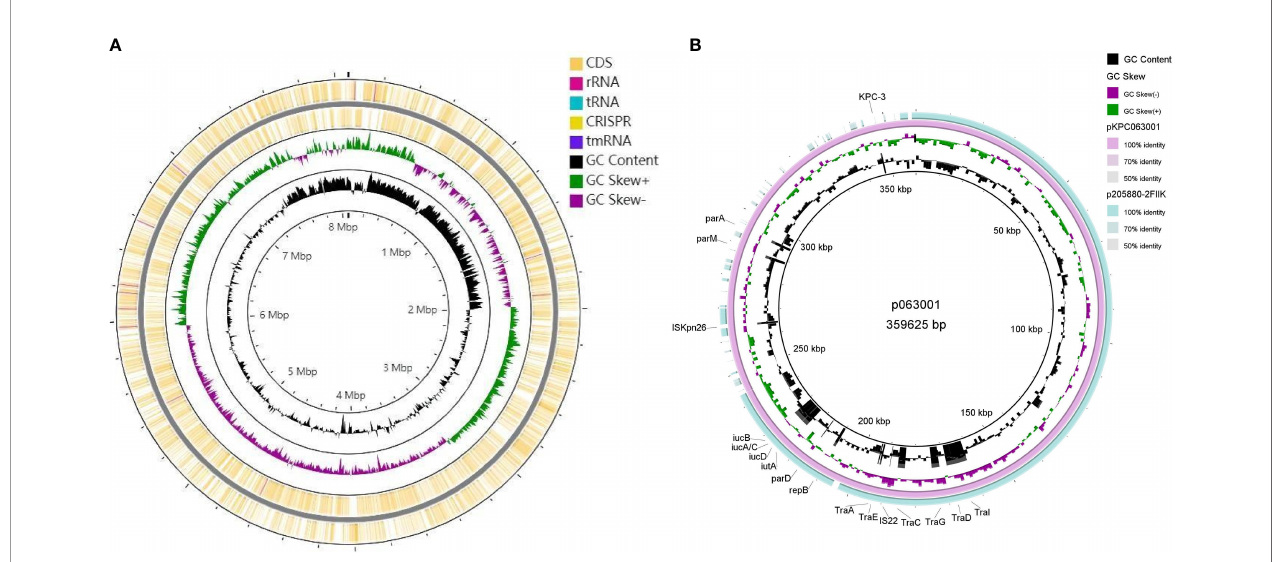
FIGURE 4 | Schematic circular genome of CRKP063. (A) Chromosome circle map. From the outside to the inside, the fi rst two circles represent the coding sequences on the positive and negative chains. The third circle represents the GC skew value. When the value was positive, the positive chain was more likely to transcribe the CDS, and when it was negative, the negative chain was more likely to transcribe the CDS. The fourth circle represents the GC content, and the outer part indicates that the GC content in this region was higher than the average GC content of the whole-genome. (B) Circle map of the IncFII plasmid carrying the bla KPC-2 gene. The outermost circle represents the plasmid p205880-2FIIK (accession no. MN824002.1), possessing high